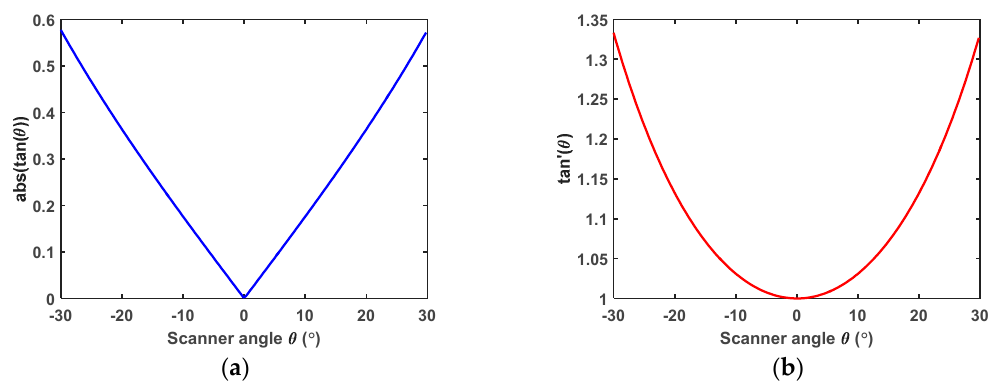
Figure 11. Different scanning angles lead to different widths of the projection fringes, even though the period with interval scanning angle is the same. ( a ) The relation between scanning angle θ and tangent value; ( b ) The relation between scanning angle θ and derivative of the tangent function.